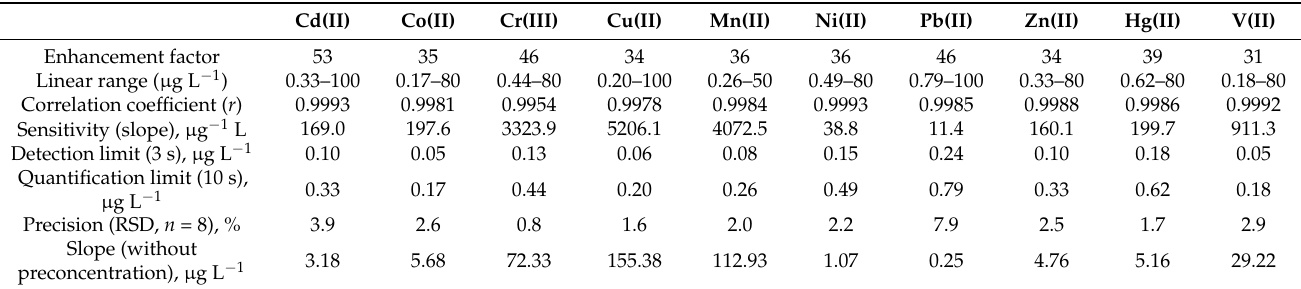
Table 1. Figures of merit of the proposed FI/ICP-AES method (for 60 s preconcentration